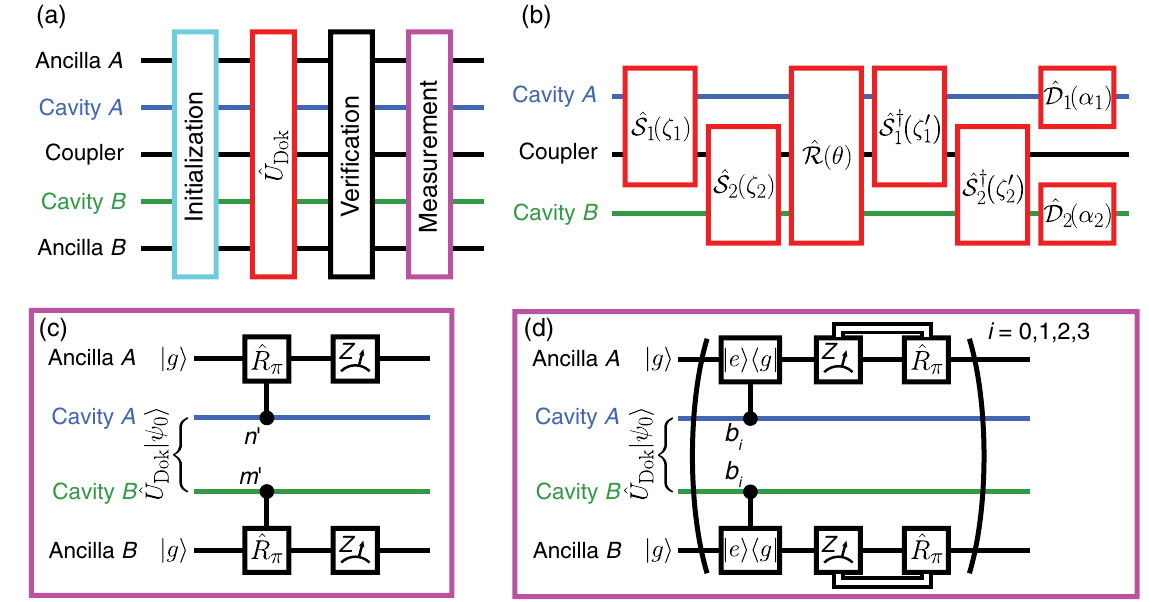
FIG. 7. Circuit implementation of the Franck-Condon simulation. (a) Overview of the quantum simulation algorithm, consisting of state preparation, unitary Doktorov transformation, and measurement. A set of verification measurements is performed after the unitary Doktorov transformation for the purpose of postselecting the final data on measuring the transmons in their ground state. (b) The two- mode circuit decomposition of the Doktorov transformation used in this experiment. The nonlinearity of the coupler transmon is primarily utilized to perform all three pumped operations, though in principle that of the ancilla transmons could have been used as well. (c) Single-bit extraction. Selective π pulses ð R π Þ flip each ancilla transmon conditioned on having n 0 and m 0 photons in cavities A and B , respectively, for a given run of the experiment. The ancillas are then simultaneously read out using standard dispersive techniques. Subsequent runs of the experiment thus need to scan n 0 and m 0 over the photon number range of interest up to the desired n (d) Sampling. Optimal control pulses are designed to excite each ancilla transmon from j g i to j e i conditioned on the value of the binary bits b of each cavity state, followed by dispersive readouts. Here, we measure the first 4 bits on a given run of the experiment, thus i resolving the first 16 Fock states for each cavity. Real-time feed-forward control is used to dynamically reset the state of the ancilla in between bit measurements to minimize errors due to ancilla relaxation.